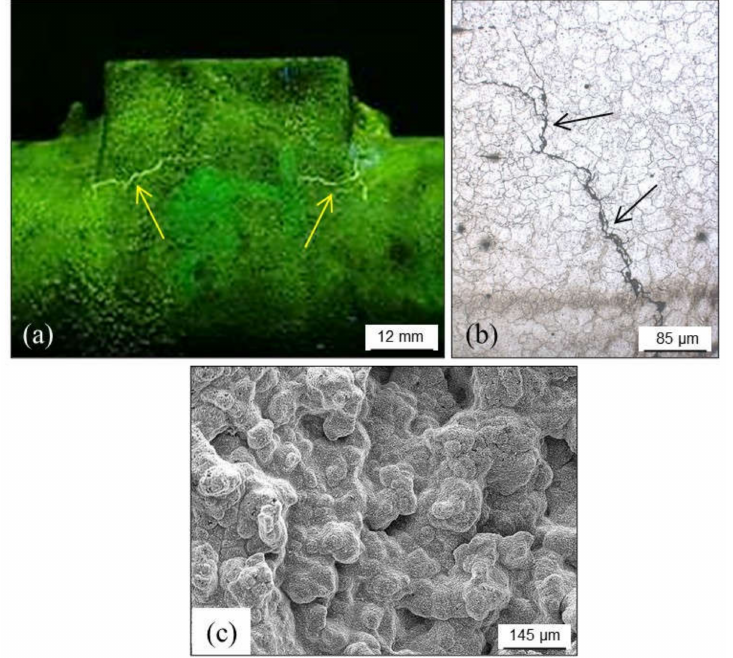
Figure 66. ( a ) Fine hot tears detected in a steel casting by using the magnetic particle inspection, ( b ) metallographic cross section of one tear showing intergranular progression and ( c ) SEM view of the internal dendritic surface of one tear showing iron oxides set on it.